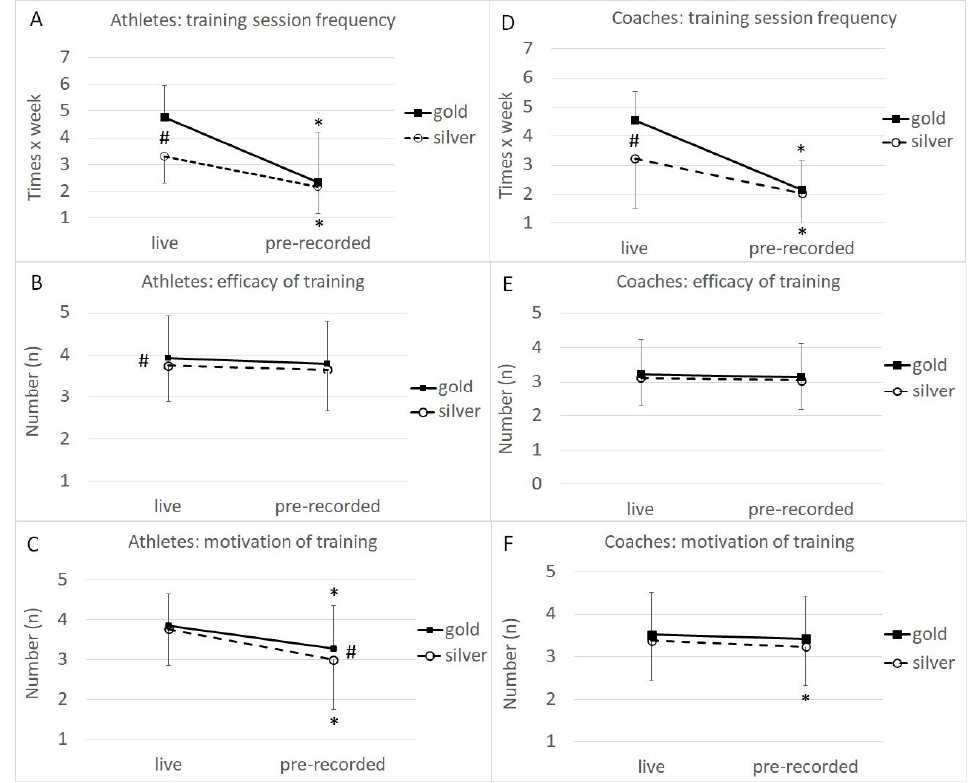
Figure 1. Effect of training modality (live streaming vs. pre-recorded) for gold (dark line) and silver (dashed line) technical level athletes ( A – C ) and coaches ( D – F ) on training session frequency ( A , D ), training efficacy ( B , E ), and training motivation ( C , F ). * p < 0.05 vs. live; # p < 0.05 gold vs. silver. Table 2. Athletes’ and coaches’ answers on training adherence and type of training performed (physical preparation, apparatus technical preparation, and free body technical preparation). Gold (n = 75)